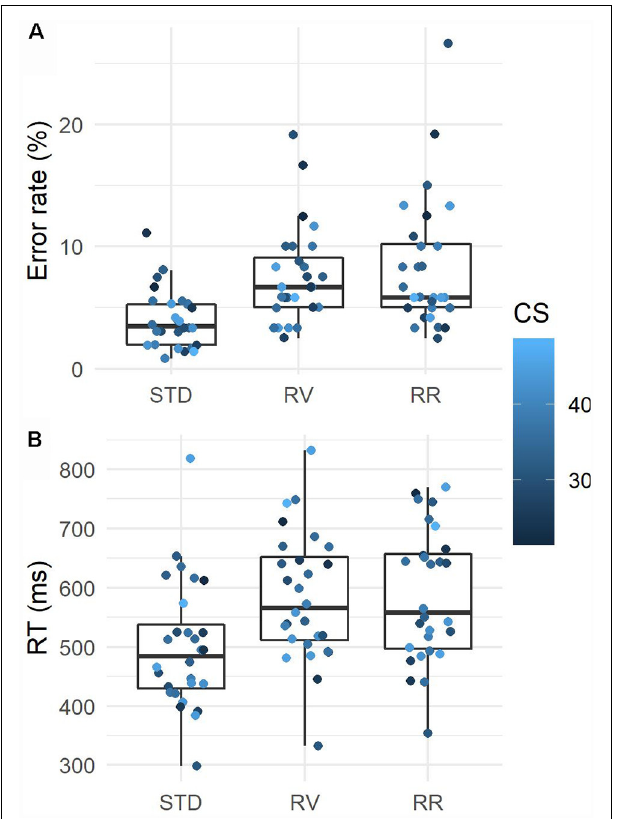
FIGURE 3 | Mean error rates (A) and response times (RTs; B ) for each instruction condition, standard (STD), rule violation (RV), and rule reversal (RR). Scatter plots display the performance as a function of conscientiousness (CS). See text for